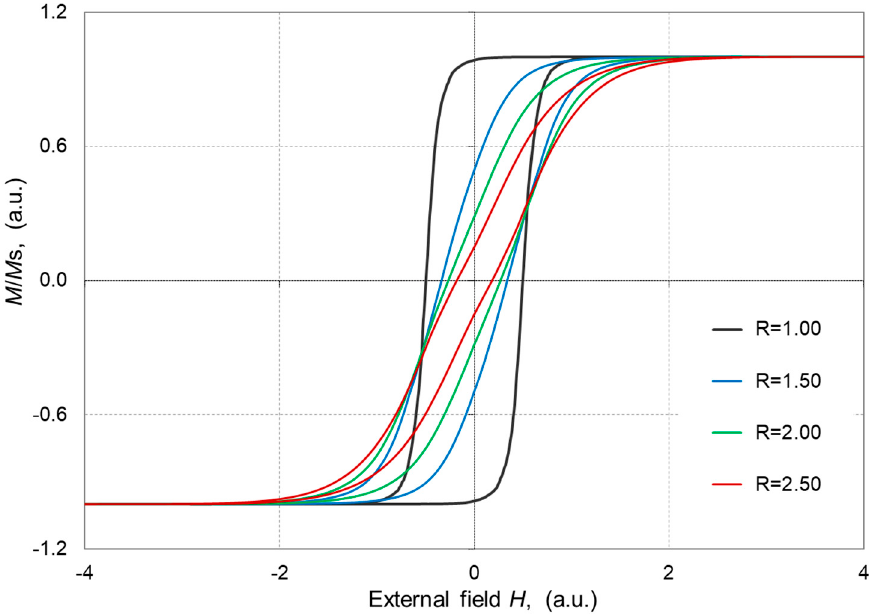
Figure 6. Normalized hysteresis loops M ( H ) for given values of disorder R ( D = 2, L = 5000, ∆ H = 0.001).